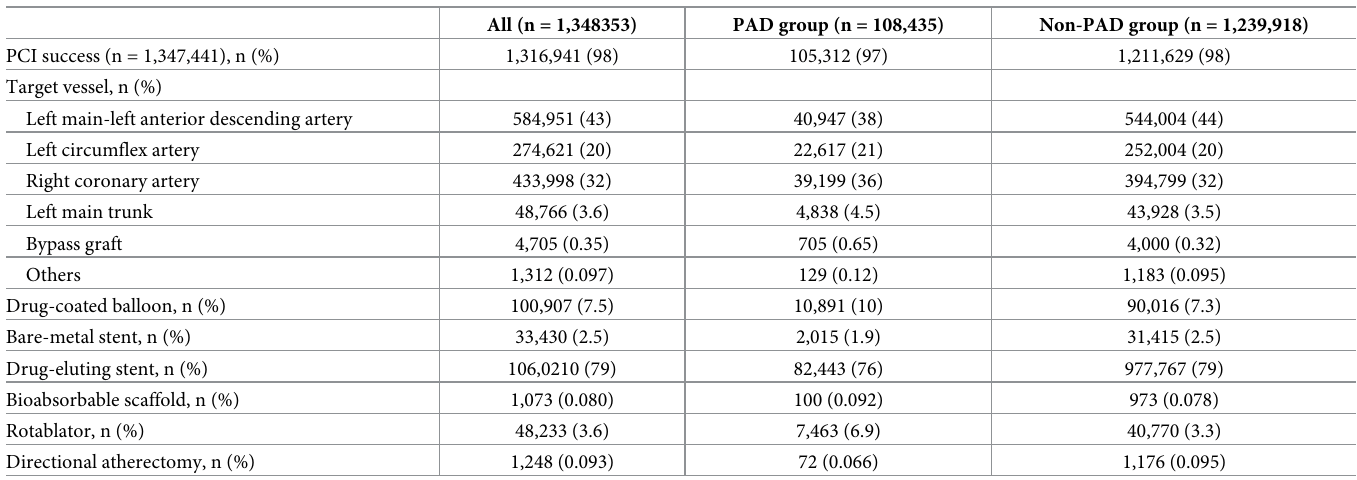
Table 2. Lesion and procedural characteristics.